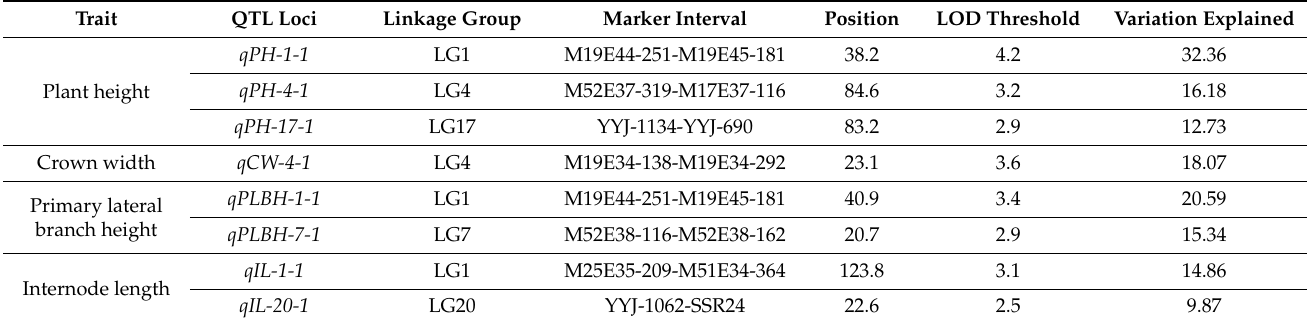
Table 3. QTLs controlling the four traits examined by composite interval